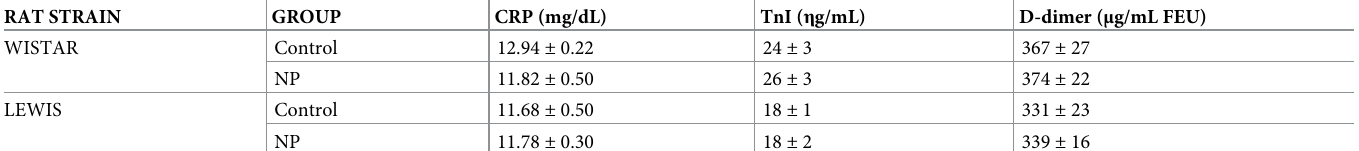
Table 2. Indirect serum biomarkers of COVID-19: C-reactive protein (CRP, mg/dL), Troponin I (TnI, η g/mL) and D-dimer ( μ g/mL FEU) evaluated in the animals of each experimental group.